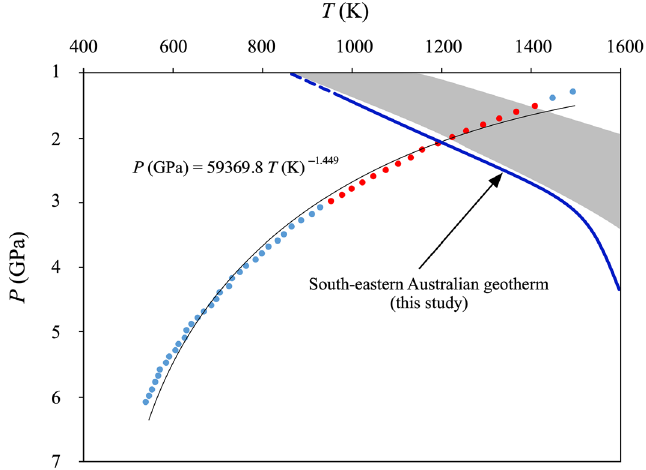
Figure 5. The dot line shows physically sound P – T locus fulfilling the reaction pargasite + forsterite = Na-phlogopite + 2 diopside + spinel. Marked in blue and in red are the P–T regions geologically incoherent and coherent with (spinel-bearing) mantle lithologies, respectively. The modelled P–T locus crosses at ~ 2.3 GPa/1190 K the geotherm calculated for this study (blue thick line) from the analysis of surface heat flow data and combining seismic tomography gravity data 88,89 . This P–T path is slightly “cooler” with respect to the Australian geotherm’s field (grey field) from literature 86,87